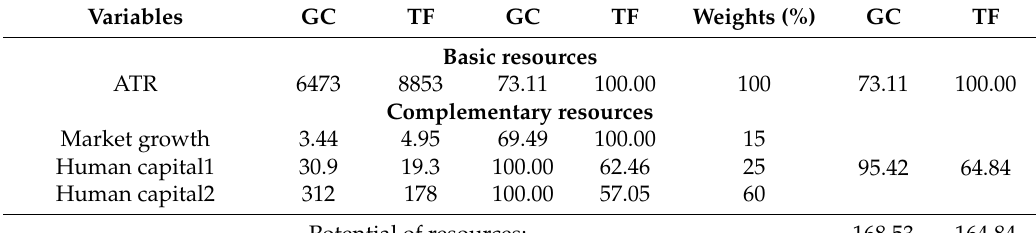
Table 3. Standardized values of resources capabilities in Gran Canaria (GC) and Tenerife